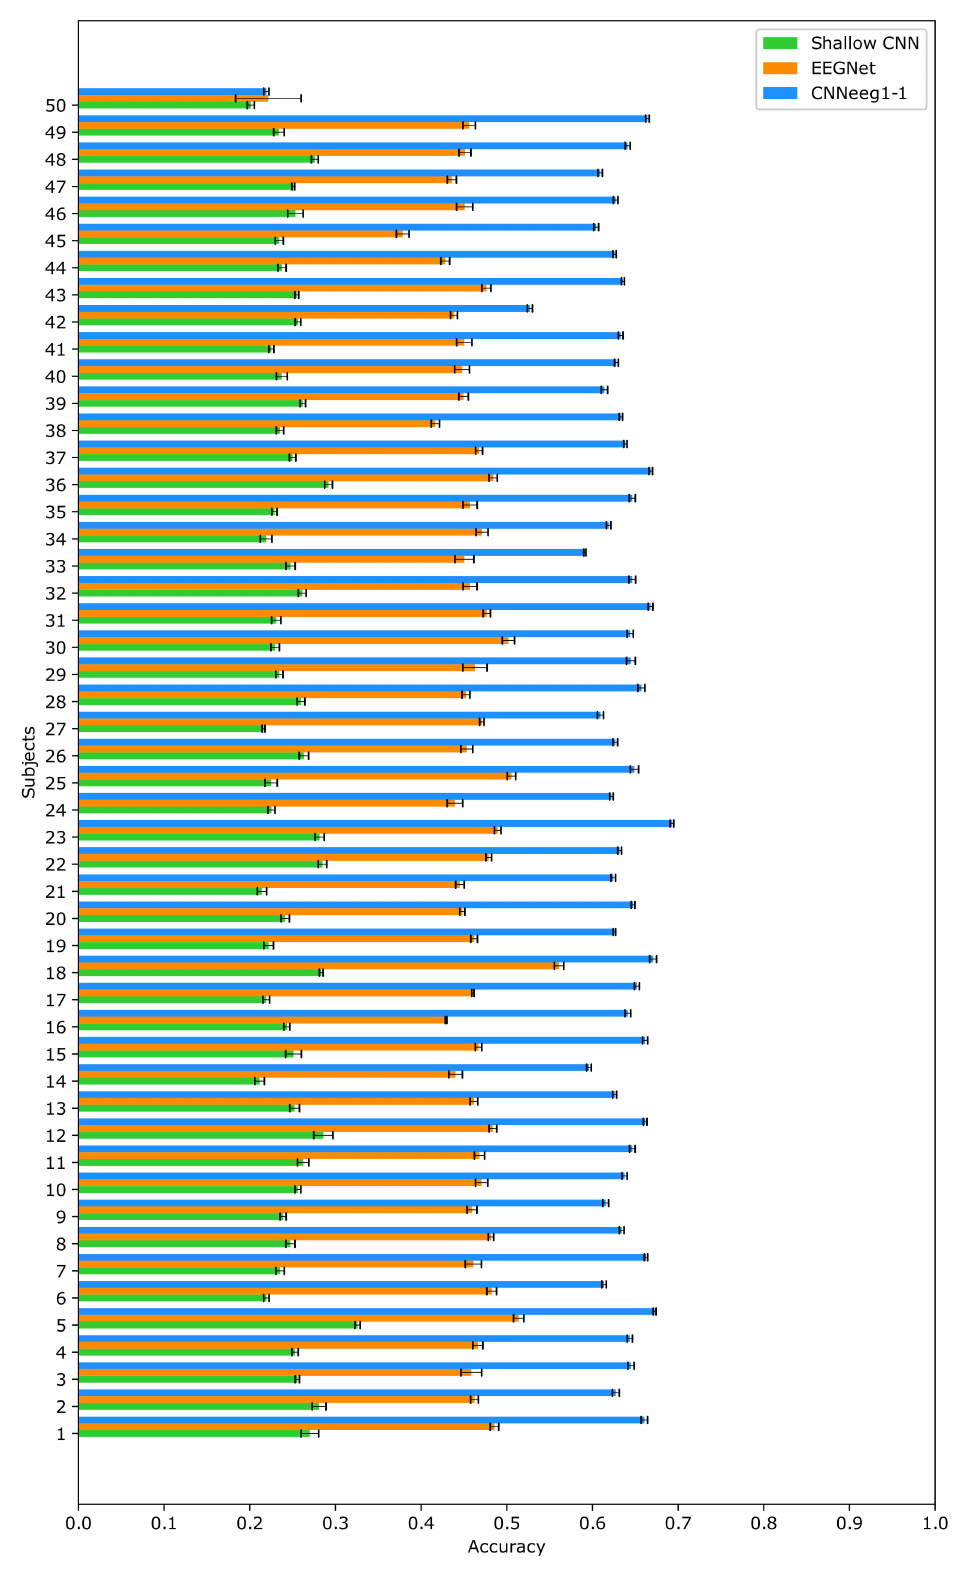
Figure 14. Inter-subject training classification accuracy for the Shallow CNN, EEGNet, and CNNeeg1- 1 algorithms using BD2